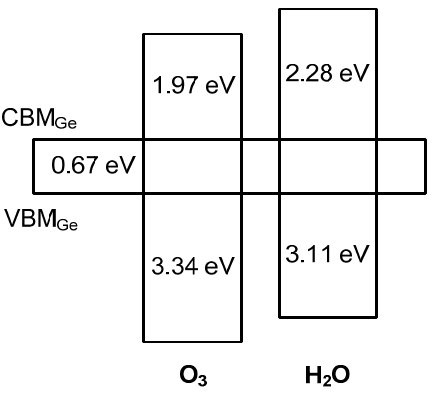
Figure 5. Results of the calculated band offsets for the La x Al y O/Ge structures with O 3 and H 2 O as oxidant.